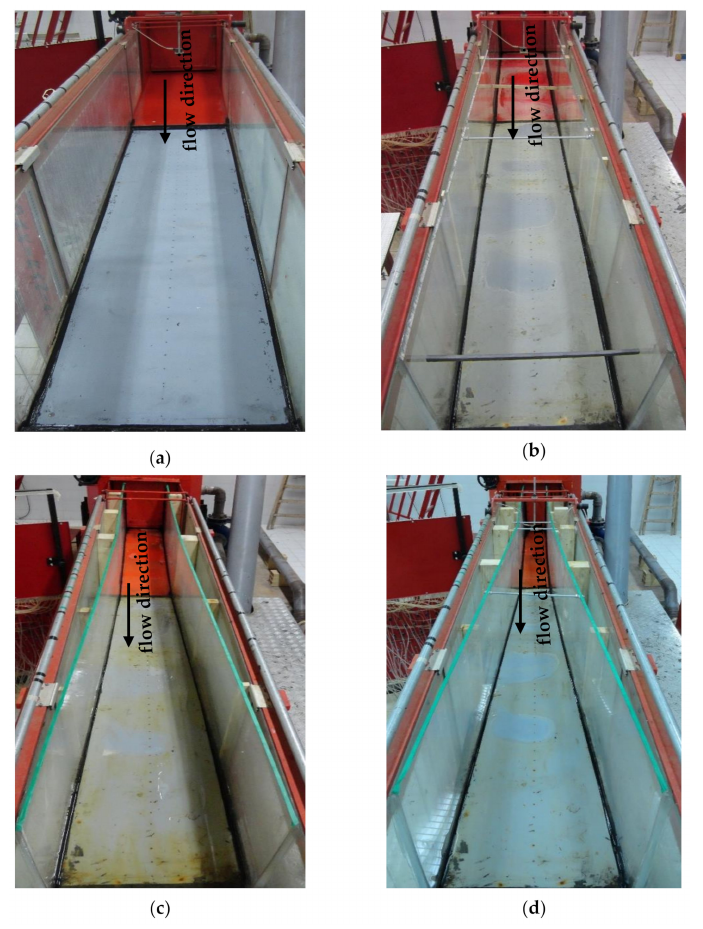
Figure 2. Sketch of gradual expanding geometry with an expansion ratio of ( b ) = 0.8, ( c ) = 0.6, ( d ) = 0.4, and ( a ) = 1 (flume without any expansion). Table 1. Main characteristics of the experiments carried out in the present study: b 1 and b 2 , upstream and downstream widths of the stilling basin; q , discharge per unit width; Fr 1 , supercritical flow Froude number; Re 1 , supercritical flow Reynolds number; y 1 , inflow depth; V 1 , average velocity of upstream; and y 2 , sequent depth of flow.